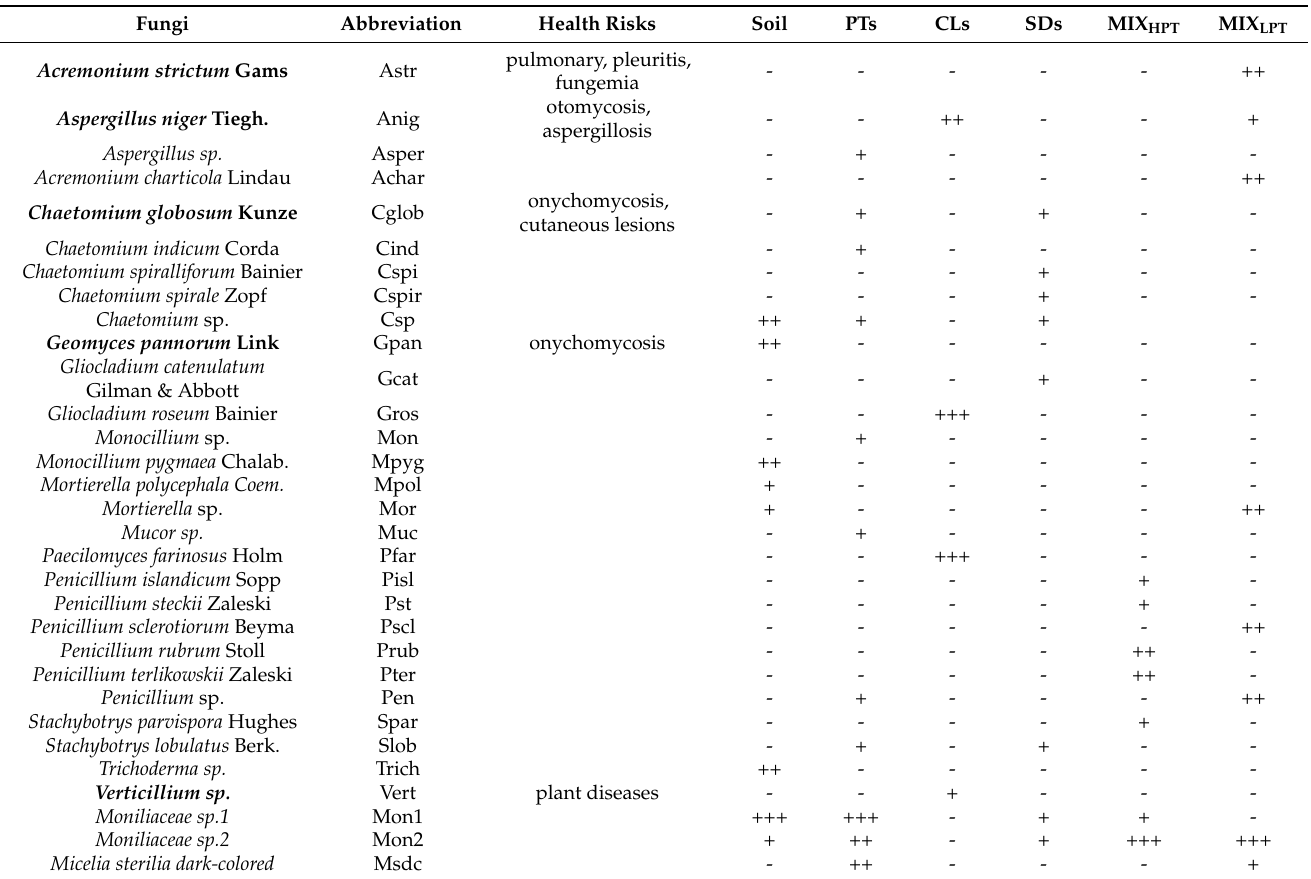
Table 4. The occurrence of the fungi in the natural soil and soil-like materials and the potential health risks from the pathogenic fungi. Bold font represents the opportunistic fungi according to risk groups 1, which indicates the dangerous of fungi’s impact on immunocompromised people (de Hoog et al.,